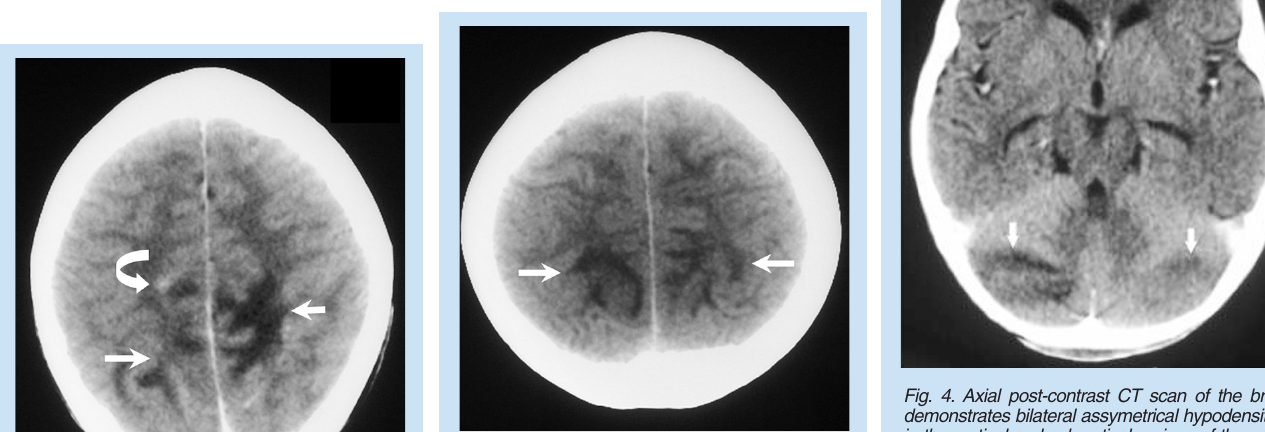
Fig. 3. Axial post-contrast CT scan of the brain shows subtle parasagittal white matter low densi- ties in the high parietal regions (arrows).